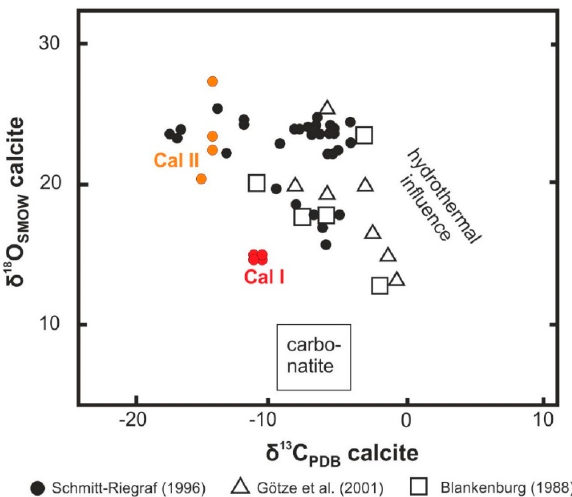
Figure 19. Stable isotope data of the two calcite generations Cal I and Cal II from Savda (JAL-31, JAL-32) in the δ 18 O / δ 13 C diagram compared to data from literature of calcite from secondary mineralization in altered volcanic rocks of di ff erent occurrences (Schmitt-Riegraf [91], Götze et al. [92], and Blankenburg [93]). The carbonatite field is defined according to Keller and Hoefs